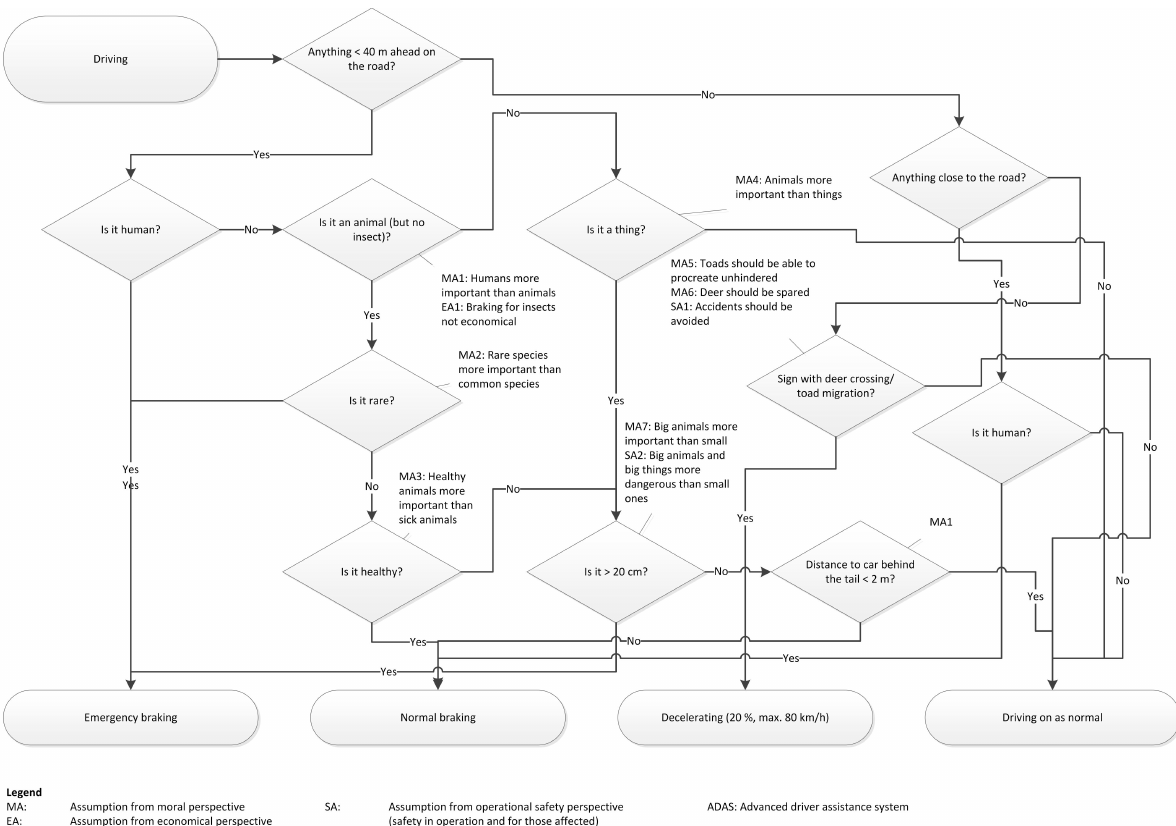
Figure 2: Annotated decision tree for an animal-friendly robot car according to [18].